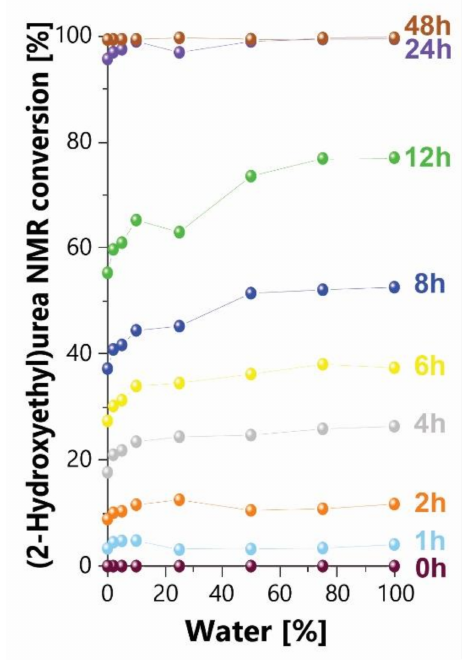
Figure 6. (2-hydroxyethyl)urea NMR conversion as a function of the water content of the ethanol- water mixture at different reaction times. The reactions were conducted with 5% v/v of ethanolamine and a 6-fold urea excess (ethanolamine/urea = 1:6) at 80 ◦